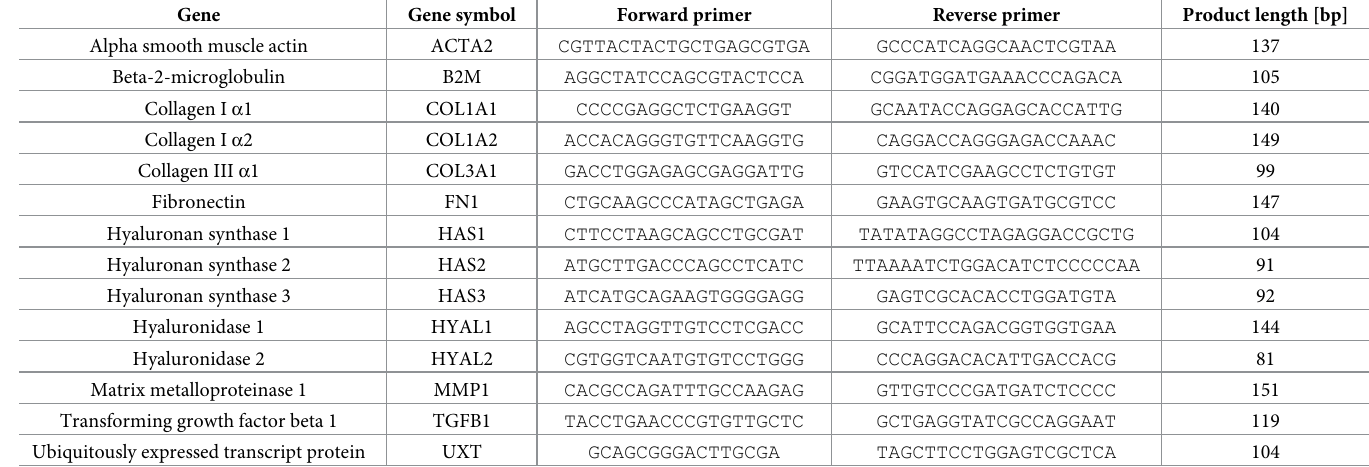
Table 1. Primer sequences used for